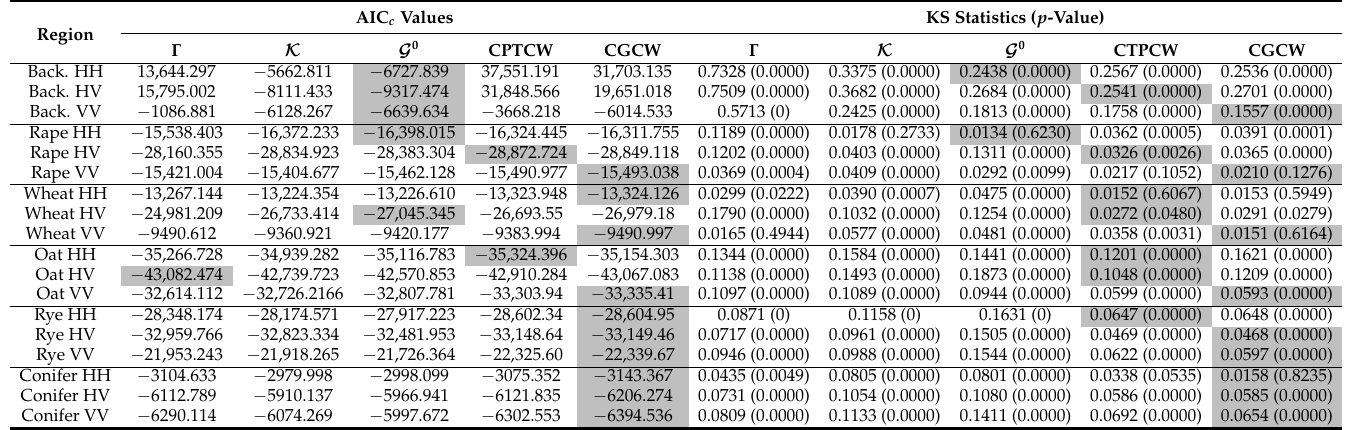
Table 6. Results of fitting intensities of Foulum PolSAR data, for L fixed.